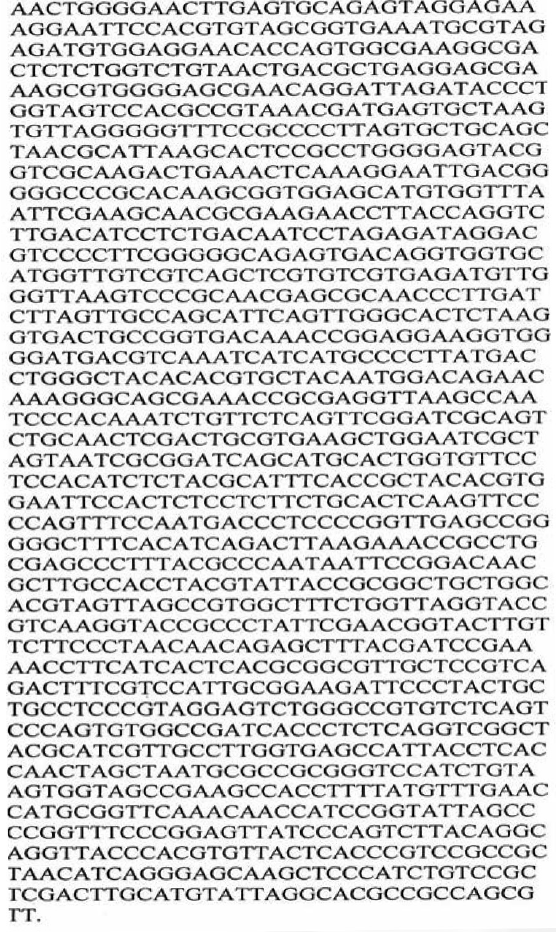
FIGURE 1 - The 16S rRNA sequence generated for isolate-1 had 1425 bases.